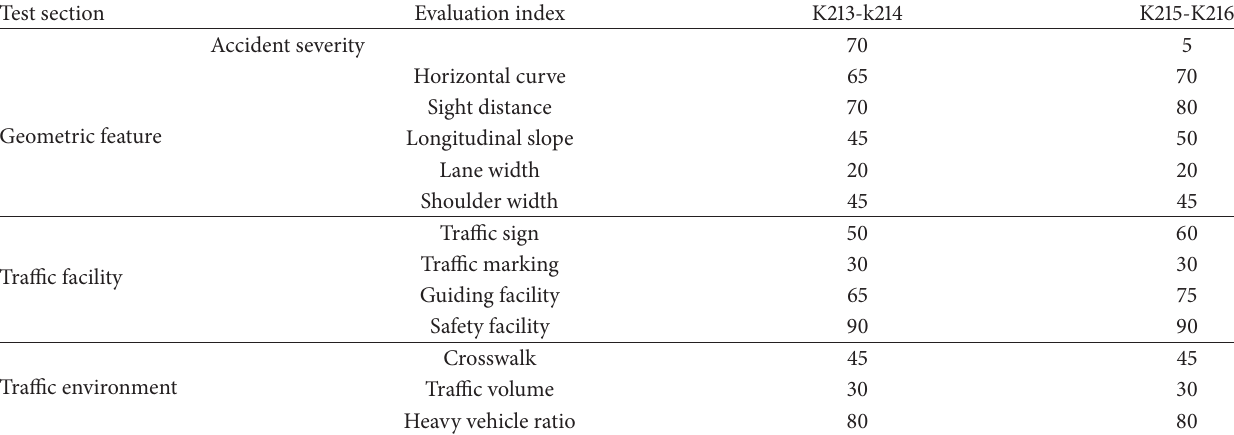
Table 16: Survey results of Hebei provincial highway S241 sections.